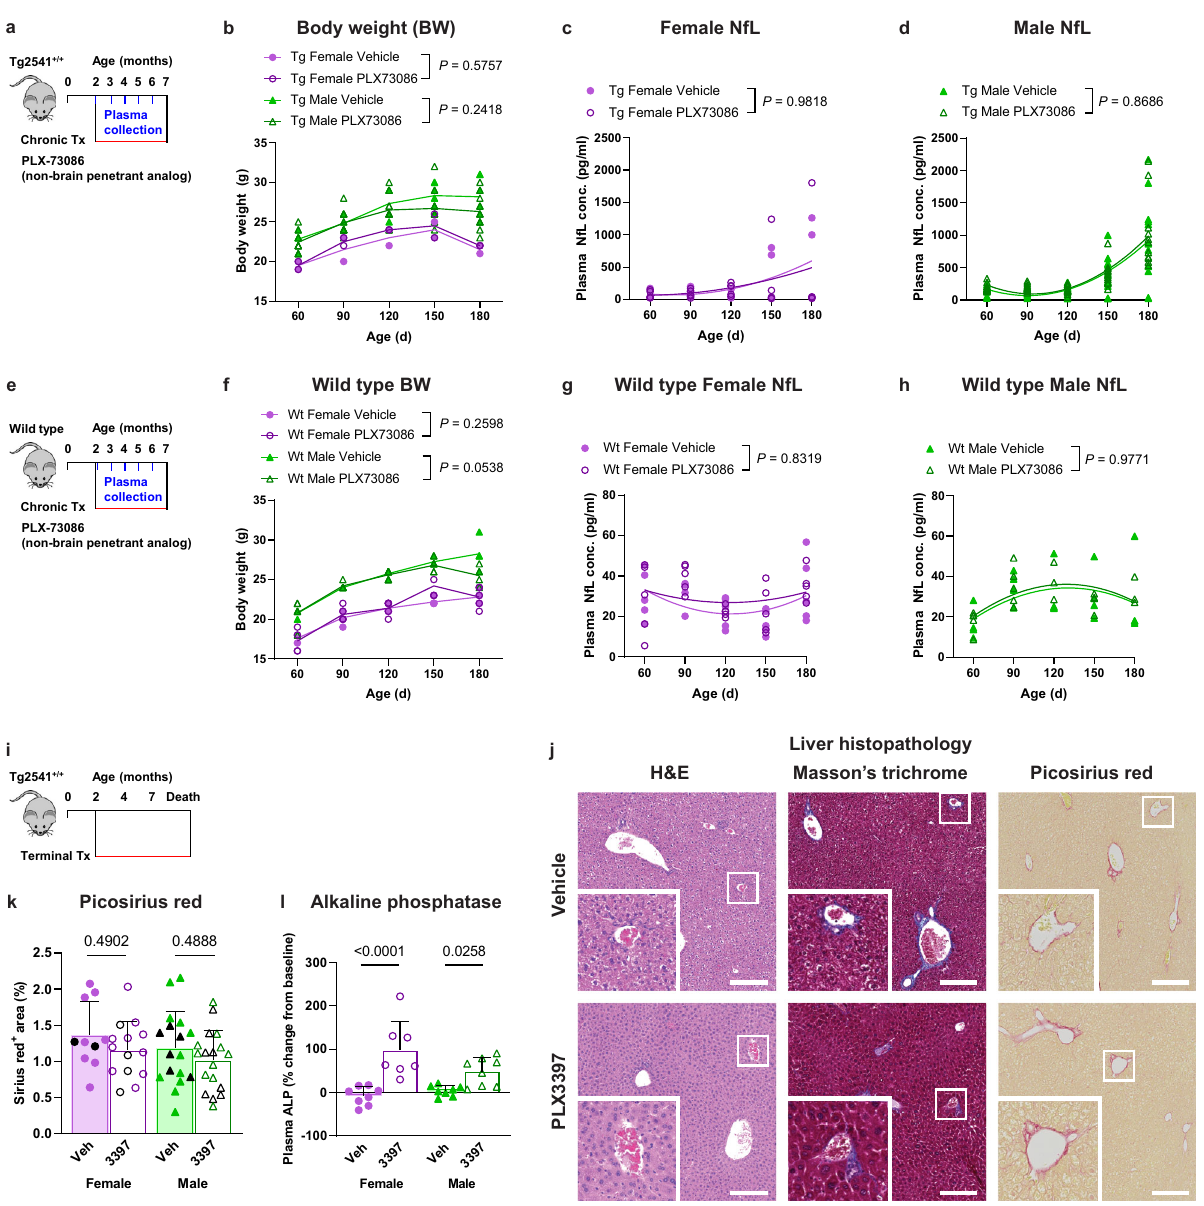
Fig. 5 | Sex-dependent effects of CSF1R are not caused by peripheral toxicity. a Schematic of chronic treatment of Tg2541 mice from 2 – 7 mo of age with PLX73086 (200mg/kg oral), a non-brain penetrant analog of PLX3397 and PLX5622. b Body weights of female or male T2541 mice treated with PLX73086. c , d PlasmaconcentrationofNfLinfemale( c )ormale( d )Tg2541micetreatedwith vehicleorPLX73086. e Schematicofchronictreatmentofwildtype(Wt)micefrom 2 – 7 mo of age with PLX73086 (200mg/kg oral). f Body weights of female or male WtmicetreatedwithPLX73086.In( b and f ),differencesinweightbetweenvehicle and PLX73086 treatment in male or female mice were evaluated by two-way repeated measures ANOVA and P values are shown. Each symbol represents an individualmouseandlinesindicategroupmeans. g , h PlasmaconcentrationofNfL in female( g ) or male ( h ) Wt micetreated with vehicle or PLX73086. In ( c , d , g , and h ), the differences between vehicle or PLX3397 treatment were evaluated by non- linear regression using quadratic models. Each symbol represents an individual mouse and the best- fi t lines and statistical results are shown. i Schematic of terminal treatment of Tg2541 mice from 2 mo of age until death with PLX3397. j Representative histopathology images of liver sections of Tg2541 mice receiving terminal treatment with vehicle or PLX3397, stained with hematoxylin and eosin (H&E), Masson ’ s trichrome, or Picosirius red. High magni fi cation insets are shown of the regions outlined with a white box. Scale bars, 200 µ m. H&E and Masson ’ s